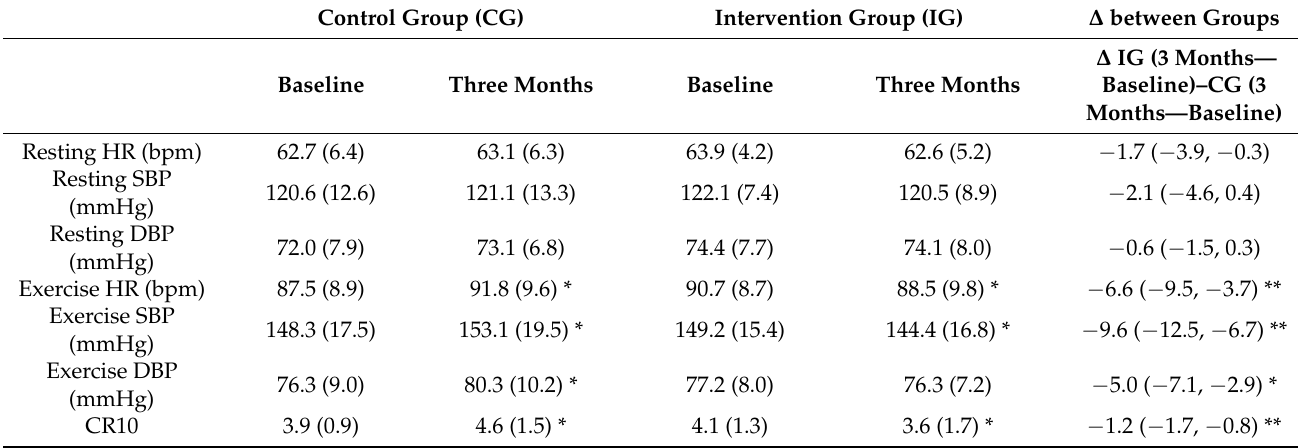
Table 3. Patients’ performance at submaximal exercise testing.